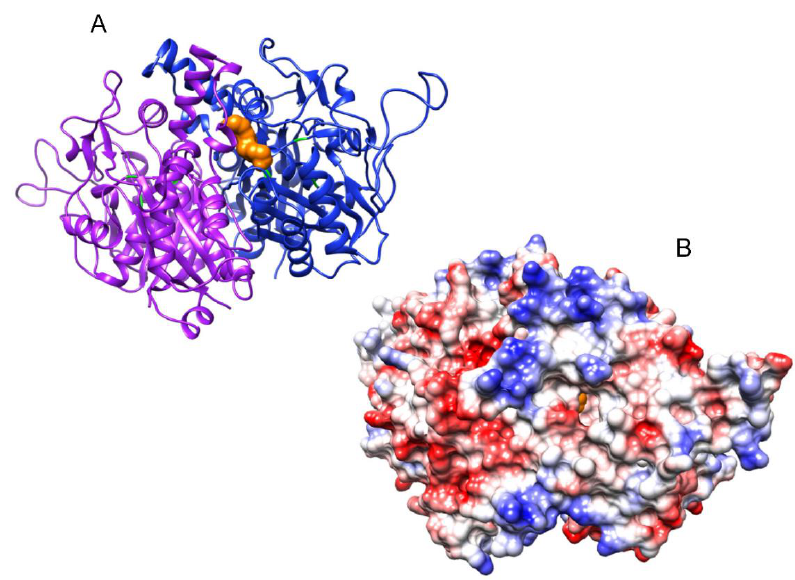
Figure 9. Proposed structural models for Arabidopsis β -ketoacyl-ACP synthase I ( At KASI; panels A , B ) homodimer based on that of Escherichia coli FabF (2gfy) [25]. Panel ( A ) is a ribbon diagram in which the catalytic triad residues are in green and the acyl chain in orange. Panel ( B ) shows the molecular surface showing the electrostatic potentials according to Coulomb’s laws with a positively charged patch pointing to the entrance of the substrate binding pocket (showing the acyl chain in orange).